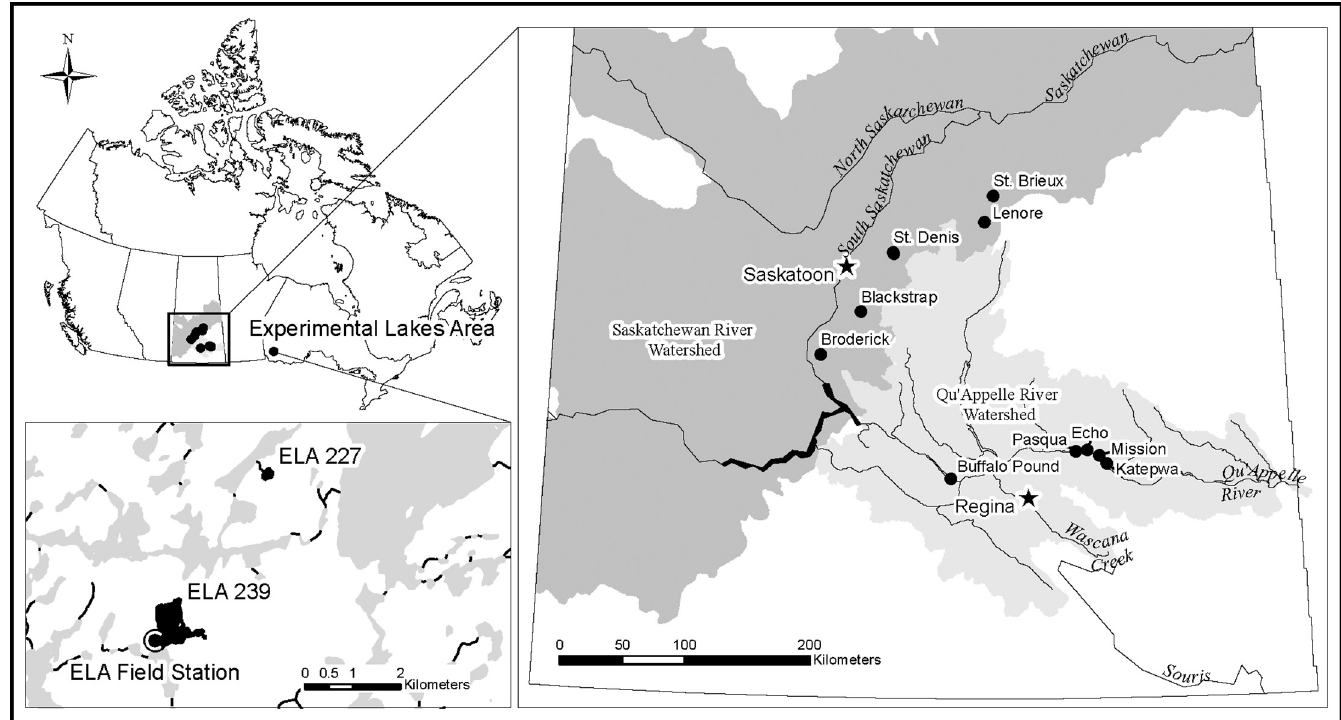
Fig 2. Map of Canada with overlays of Saskatchewan and Ontario study sites (map courtesy of Rosa Brannen). All Saskatchewan sites are in the prairie ecozone, while the Experimental Lakes area sites are in the boreal shield ecozone [42].